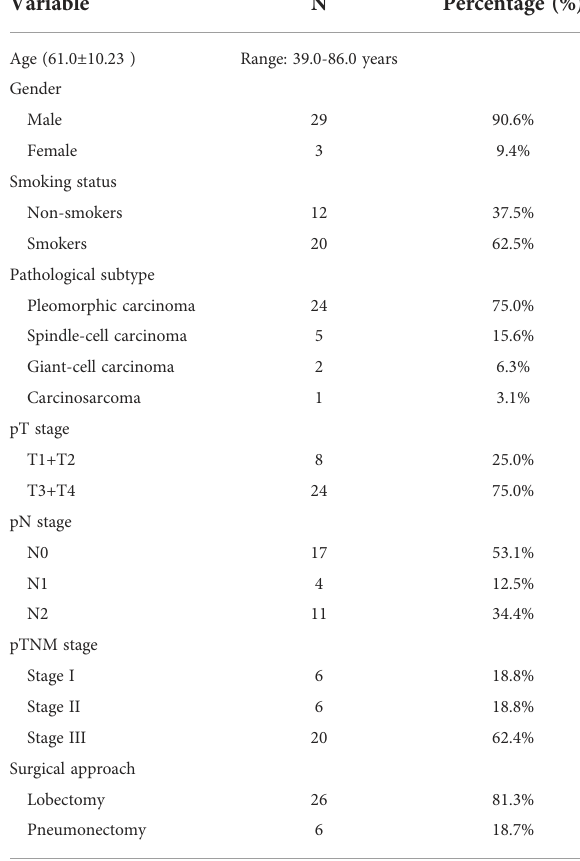
TABLE 1 Clinicopathological characteristics of patients with PSC